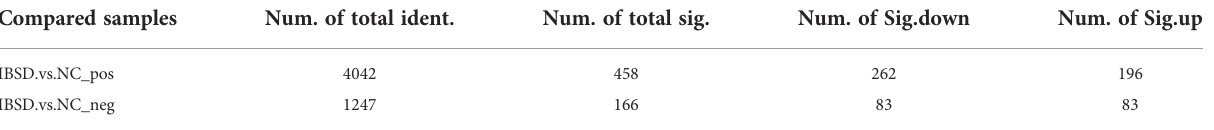
TABLE 4 Differentially expressed metabolites identi fi ed by LC – MS. Compared samples Num. of total ident. Num. of total sig. Num. of Sig.down Num. of